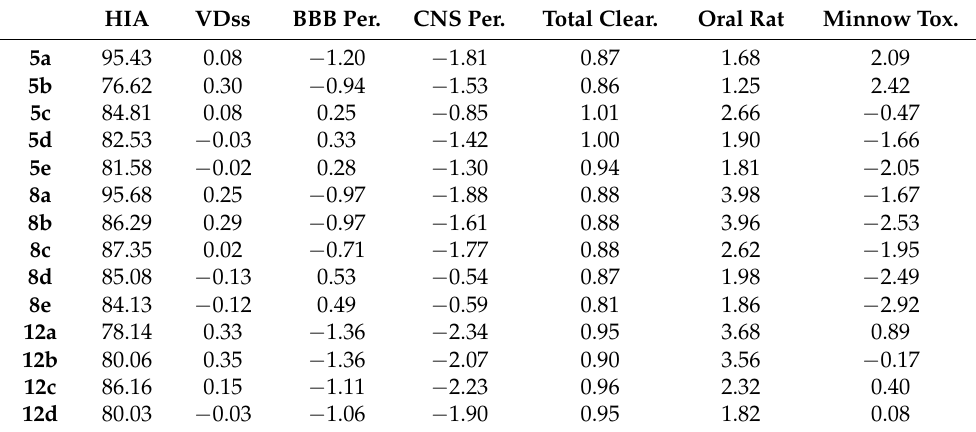
Table 3. Pharmacokinetic properties calculated by pkCSM program. HIA VDss BBB Per. CNS Per. Total Clear. Oral Rat Minnow